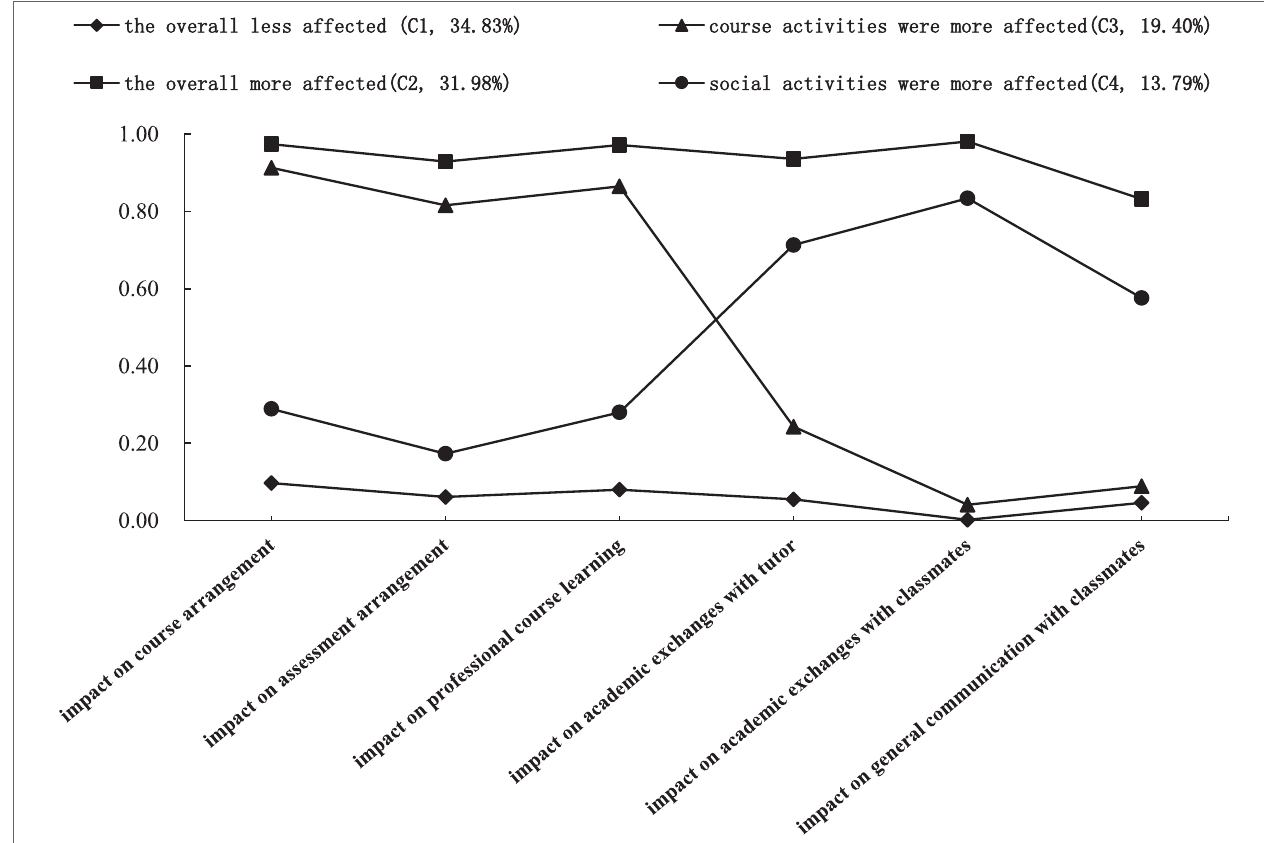
FIGURE 1 | Conditional probability distribution diagram of each latent